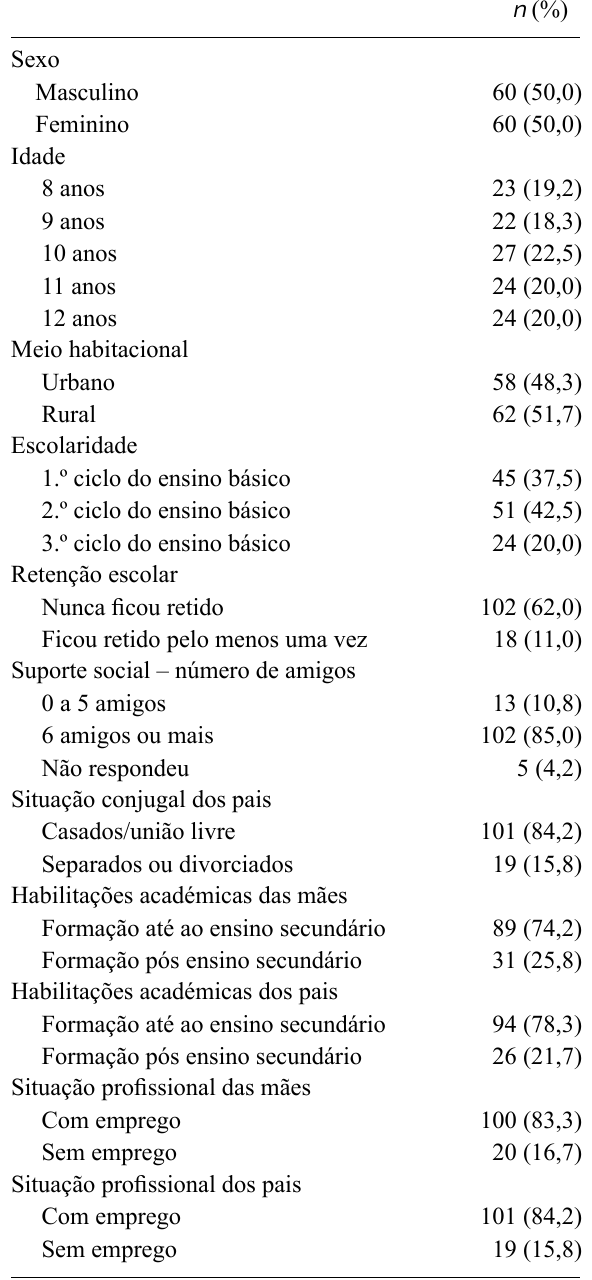
fi cas dos participantes e dos seus pais, com idades